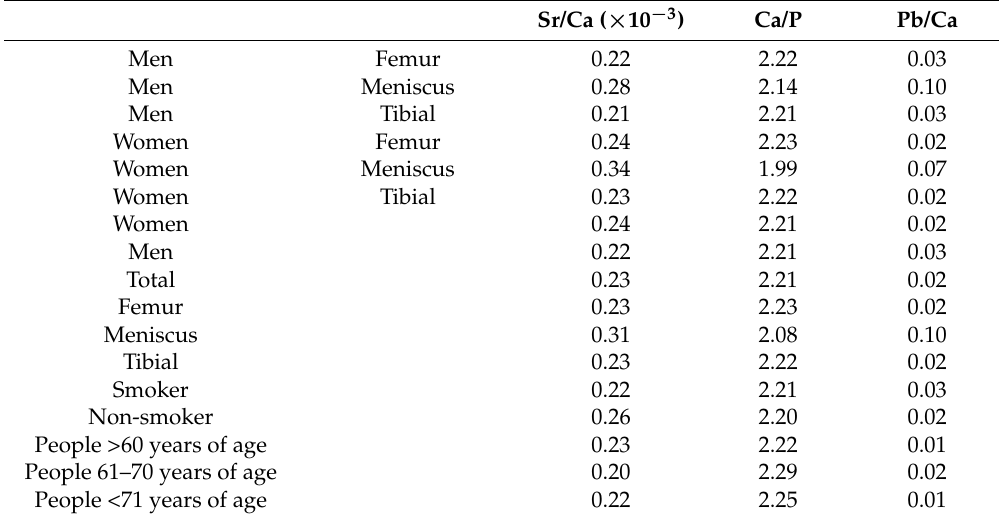
Table 4. The ratios of the elements in tissues of the knee